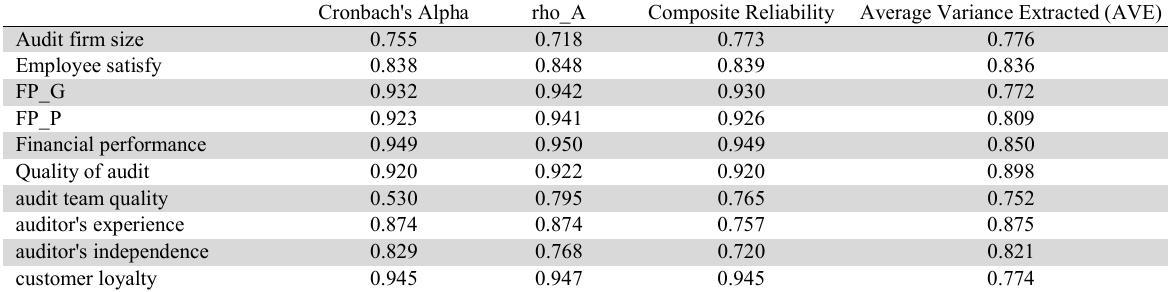
Construct Reliability and Validity